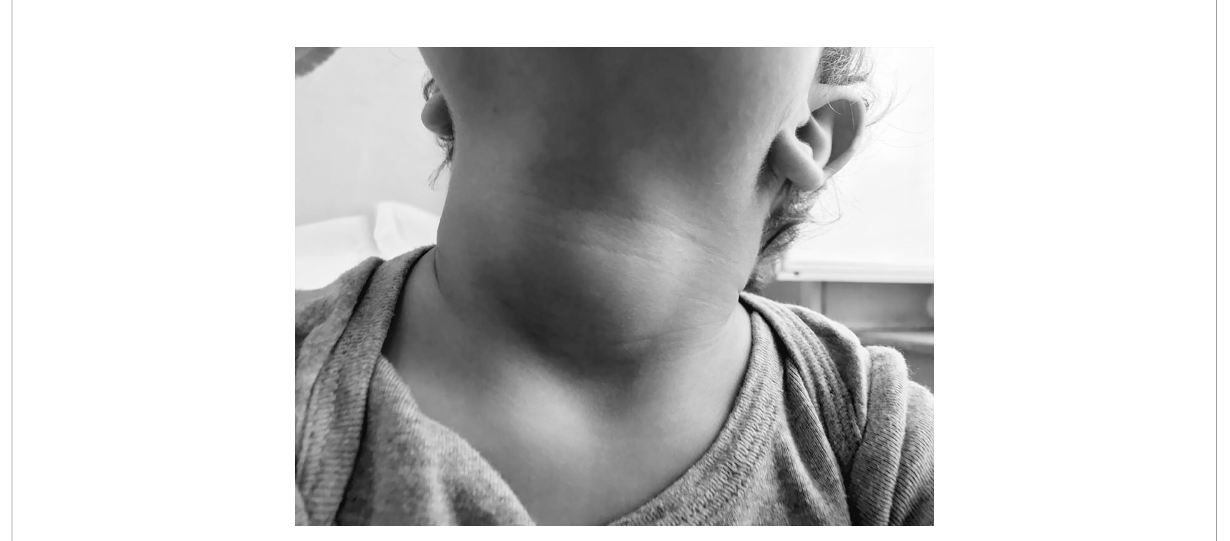
FIGURE 1 Child ’ s neck at diagnosis: thyroid gland was considerably increased in size, soft, non tender and freely movable with